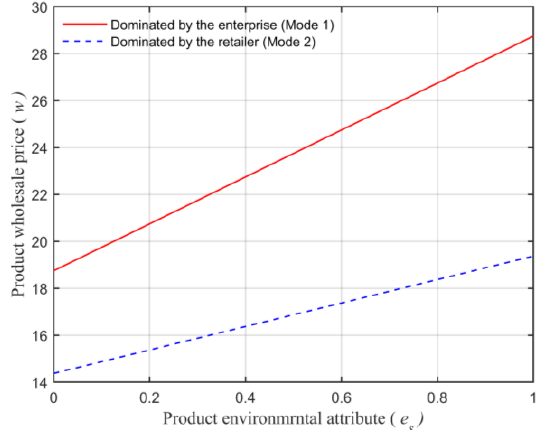
Figure 4. The relationship between the product environmental attribute and the product’s wholesale price.